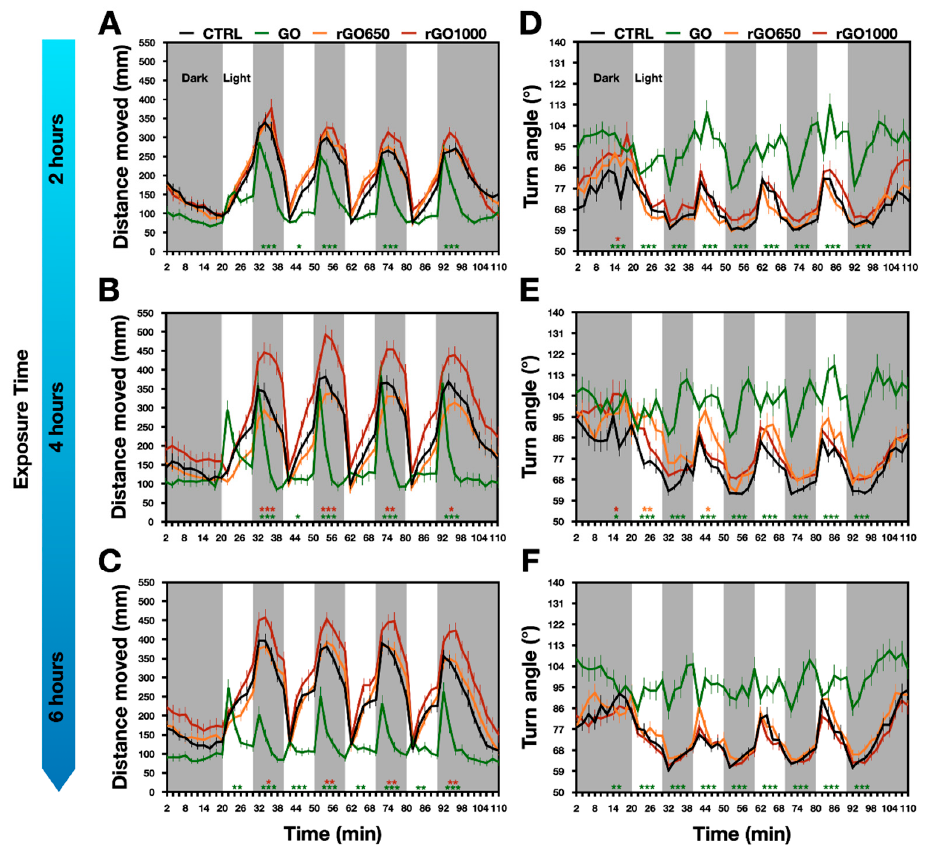
Figure 2. Impact of GRMs with different degrees of thermal reduction on locomotor behavior upon 2, 4 and 6 h-long treatments. Locomotor activity was analyzed by measuring the distance moved and the turn angle (left and right columns, respectively). Animals were subjected to light (white bars) and dark (grey bars) alternating periods of 10 min each one. The controls (CTRL) are showed in black, GO in green, rGO650 in orange and rGO1000 in red. ( A – D ) Line plots after 2, ( B – E ) 4 and ( C – F ) 6 h of treatment. Results are expressed as Mean ± SEM of 2 min per bins. Statistical significance of treatment respect to the CTRL are expressed as * p < 0.033, ** p < 0.002, *** p < 0.001 and refers to 10 min of behavioral recordings, the entire light or dark period of stimulation.